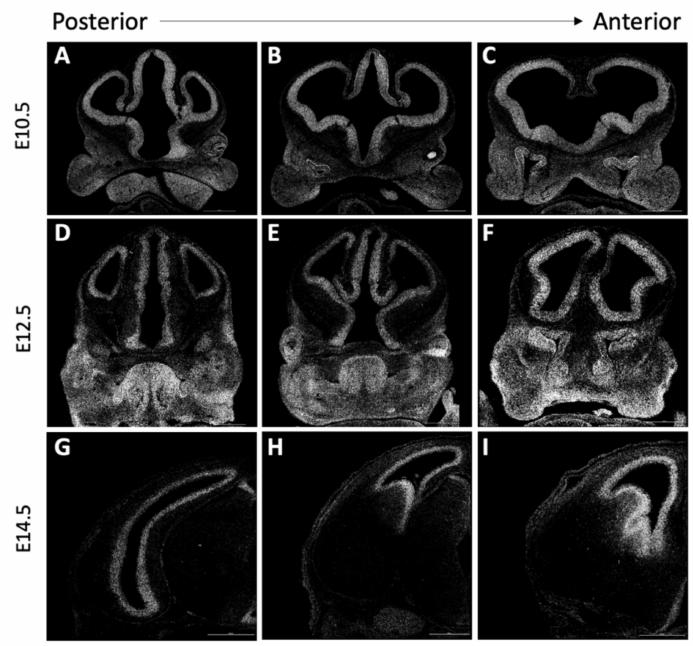
Figure 3. RNAscope shows wild-type Cse1l expression is localized to cortex and specific regions of the face and eyes . ( A–F ) RNA expression of Cse1l in wild-type embryos is widespread throughout the brain and face, and in later stages ( G – I ), becomes more localized around the lateral ventricles.